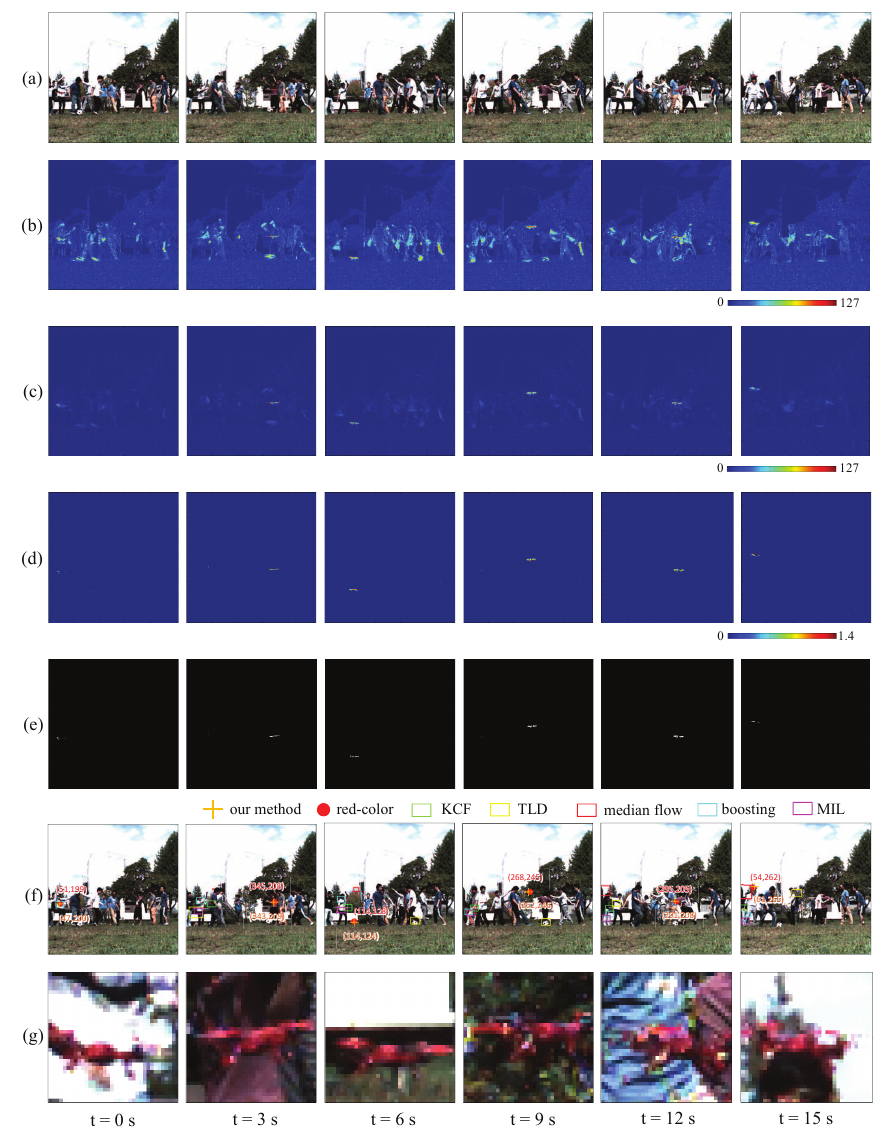
Figure 21. ( a ) Input images; amplitude of ( b ) input; and ( c ) pixel-wise filtered images; ( d ) amplitude ratios; ( e ) extracted vibration features; ( f ) tracked positions; ( g ) magnified